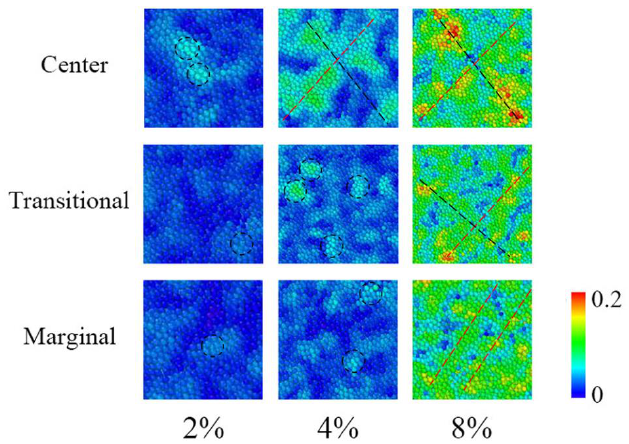
Figure 10. A sequence of images that demonstrate the evolution of η iMises in the center, transitional, and marginal regions, corresponding to strains of 2%, 4%, and 8%, respectively. The circles indicate the localized regions with relatively high η iMises values. The black and the red dashed lines denote